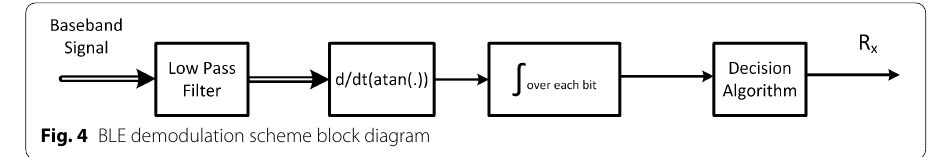
Fig. 3 Frequency spectrum of a BLE signal